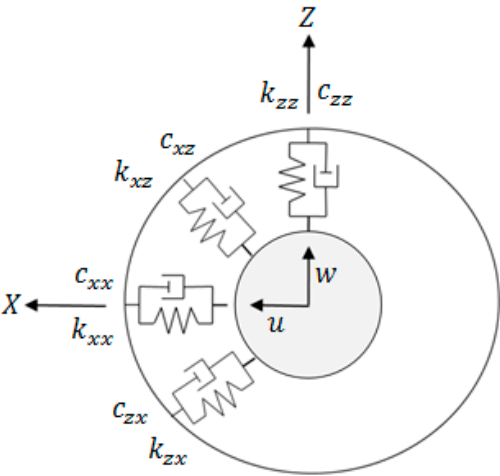
Figure 2. Stiffness and damping parameters in bearings [40].